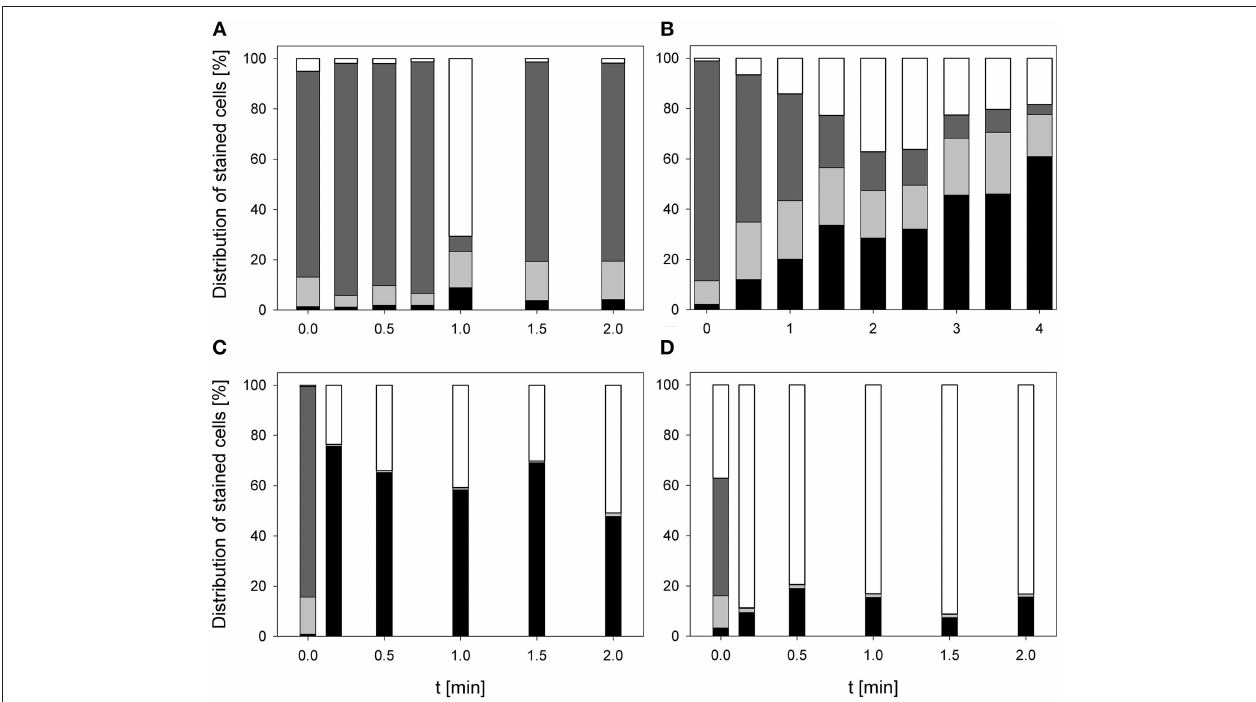
FIGURE 5 | Membrane integrity of L. innocua after PAA treatment [(A) 10 ◦ C, 0.25% PAA], CAPP treatment [(B) 20 W], and treatment with ozonated water [(C) 3.42mg l − 1 O 3 (–); (D) 3.8mg l − 1 O 3 ( + )]. Black bars representing permeabilized cells; gray bars representing slightly permeabilized cells, light gray bar representing intact cells, and white bars representing cells without fluorescence/cell